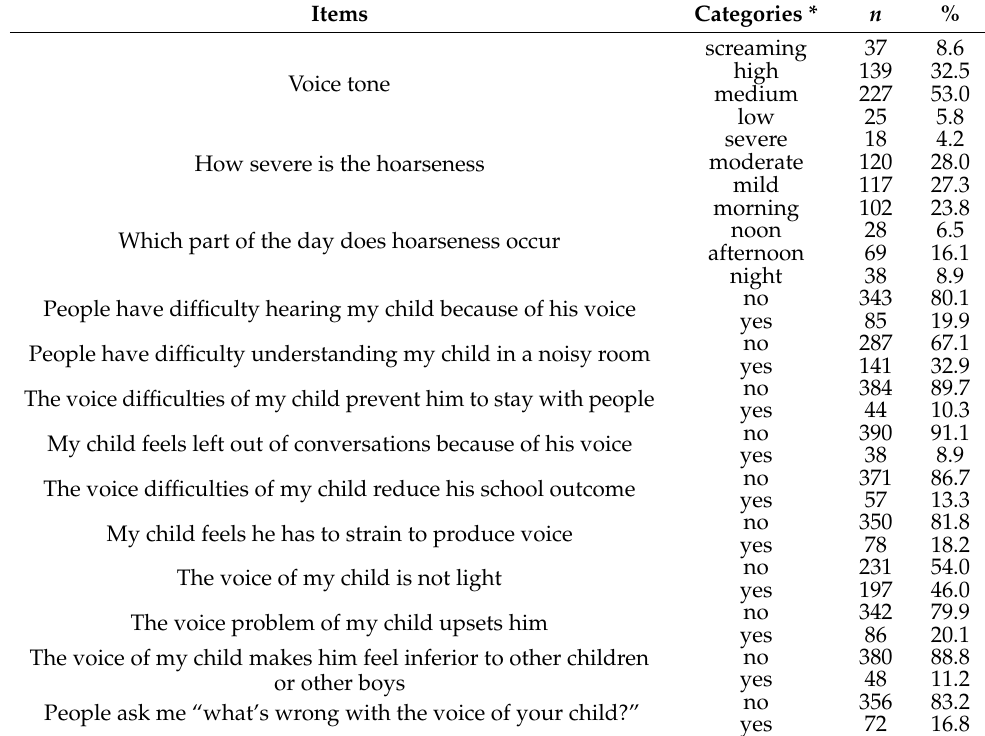
Table 2. Distribution of voice hoarseness indicators measured using the Children’s Voice Handicap Index-10 for